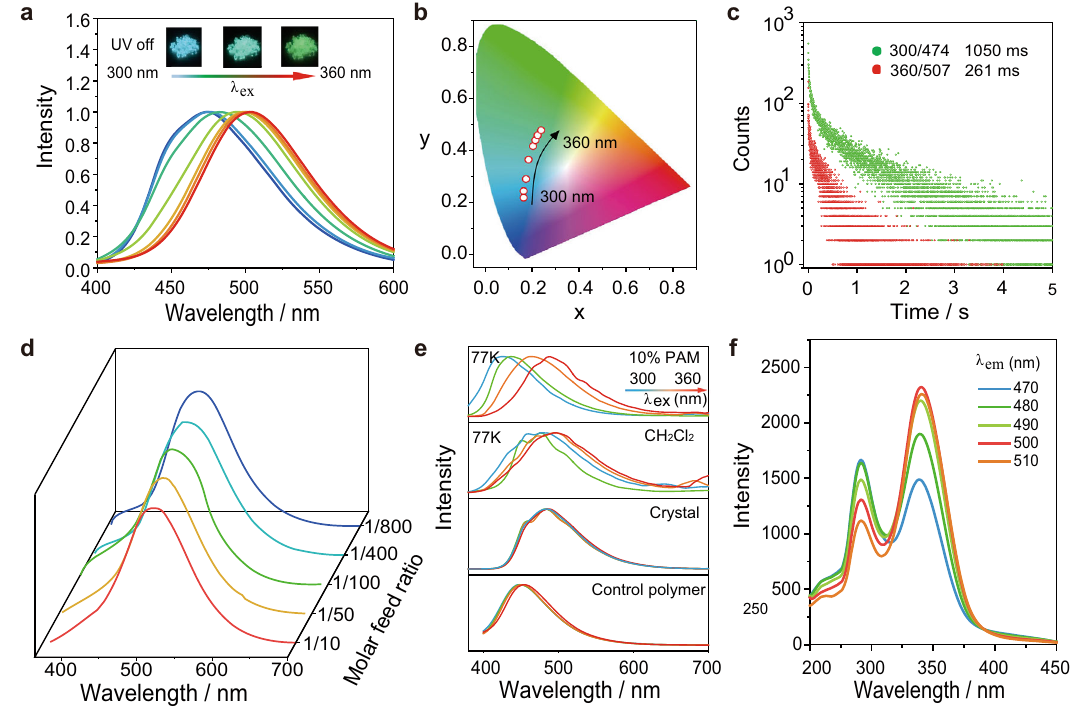
Fig. 2 | Ex-De persistent RTP and mechanism study. a Ex-De phosphorescence spectraofP1uponchangingexcitationwavelengths. b CIEchromaticitydiagramfor P1atvariousexcitationwavelengths. c LifetimedecaycurvesofP1inthesolidstate. d Phosphorescence spectra of P1 at different ratios (1/10 – 1/800) under 340nm